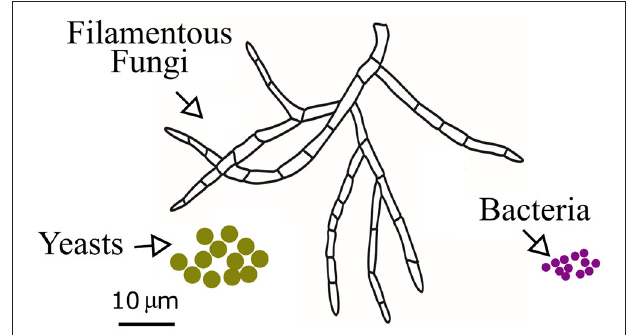
FIGURE 1 | The main morphological and size differences between filamentous fungi, yeast, and bacteria, showing that the fungal branching architecture could provide more nucleation sites and framework support for the calcium carbonate